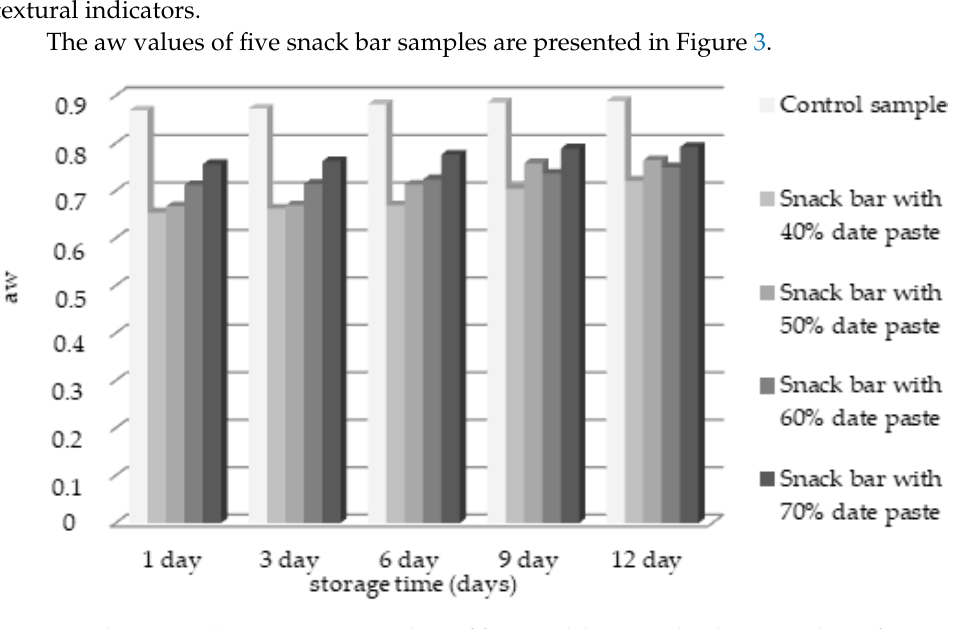
Figure 3. Changes in the water activity values of five snack bar samples during 12 days of storage. The highest water activity aw (ranged between 0.869 and 0.889 during the storage period) was observed in the control sample formulation. The lowest aw (between 0.654 (40%). An increasing trend was observed in the